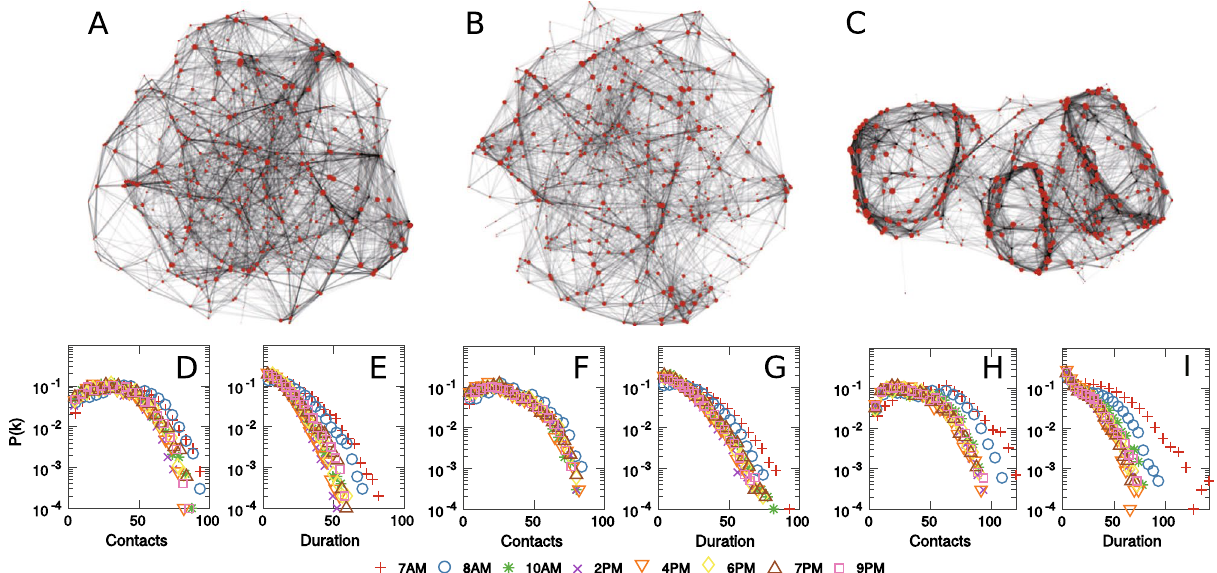
Figure 2. Simulated MCNs with 500 nodes and the unweighted and weighted degree distributions of simulated MCNs with 1000 nodes. ( A )–( C ) visualizes the layouts of the simulated MCNs in Guangzhou, Shanghai and Shenzhen. In the visualization, larger node size reflects higher node degree and the transparency of the link is proportional to the duration of contact. ( D ), ( F ) and ( H ) present the probability density function of the unweighted degree distributions of Guangzhou, Shanghai and Shenzhen. ( E ), ( G ) and ( I ) present the probability density function of weighted degree distributions of Guangzhou, Shanghai and